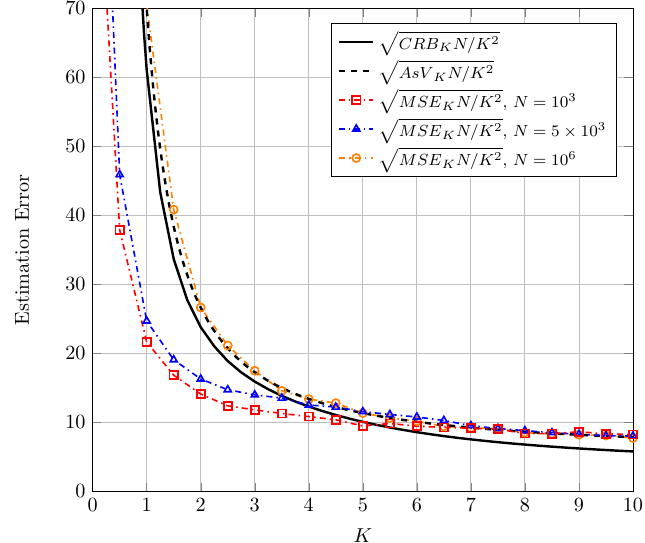
Figure 5. Sqrt-normalized MSE K for the estimation of K using Equation (14) for ∆ = 0.5 and different number of observations N . Also shown are the corresponding sqrt-normalized AsV K and sqrt-normalized CRB K